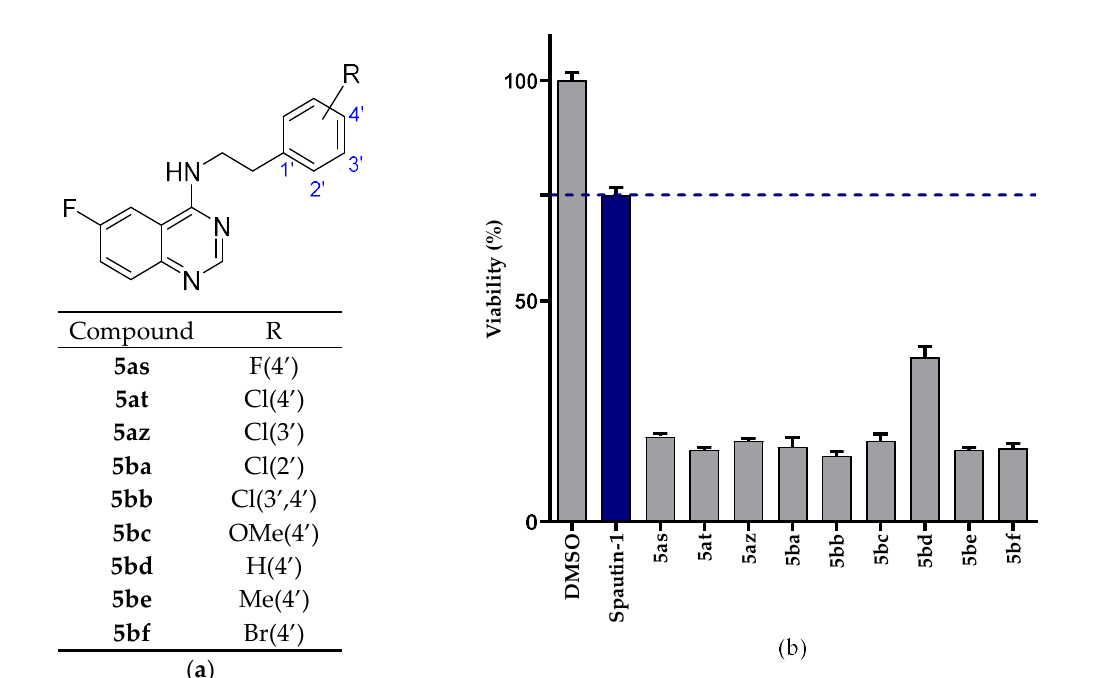
Figure 9. ( a ) Spautin-1 analogues with an extended chain length; ( b ) viability assay (5 µ M) with Spautin-1 as reference.